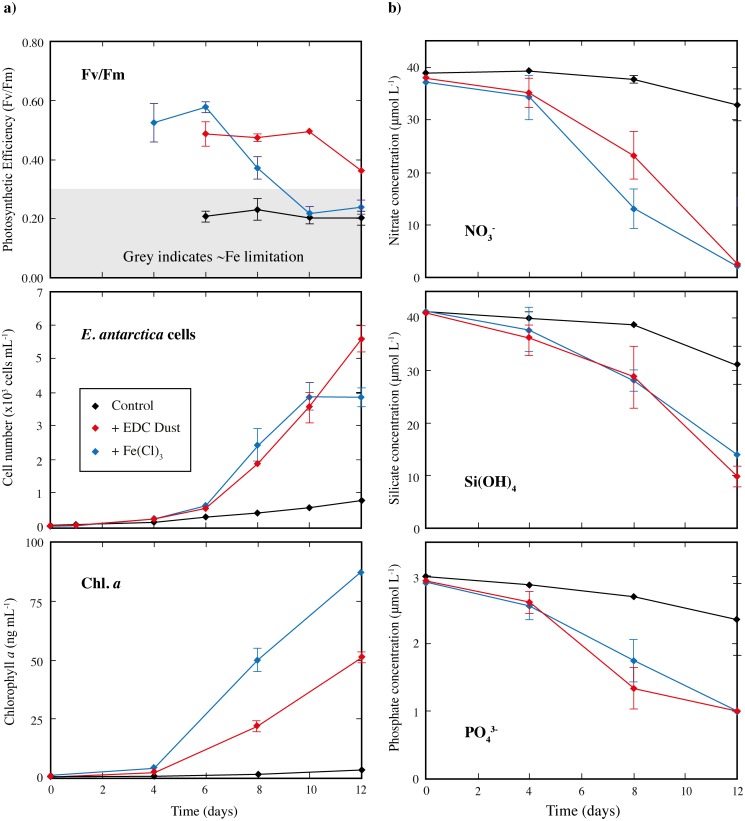
a) The growth of Eucampia antarctica under different conditions (control or in response to iron chloride (+FeCl3) or dust (+dust) addition), over 12 days. Photosynthetic efficiency (Fv/Fm), diatom cell number and chlorophyll a concentration are shown. b) Nutrient concentration in different incubations of E. antarctica over the course of each experiment. Nitrate (NO3-), silicate (Si(OH4)) and phosphate (PO43-) are shown. The initial values were measured in the 8 L canister, prior to subdivision into five 1 L bottles, and these values are shown for time = 0. After this, the mean of measurements in the replicate bottles is shown (n = 3 or n = 5 for final measurement), with error bars denoting ± 1SD (where bigger than the size of the symbol). The grey bar indicates Fv/Fm values that are considered to represent cells under stress.